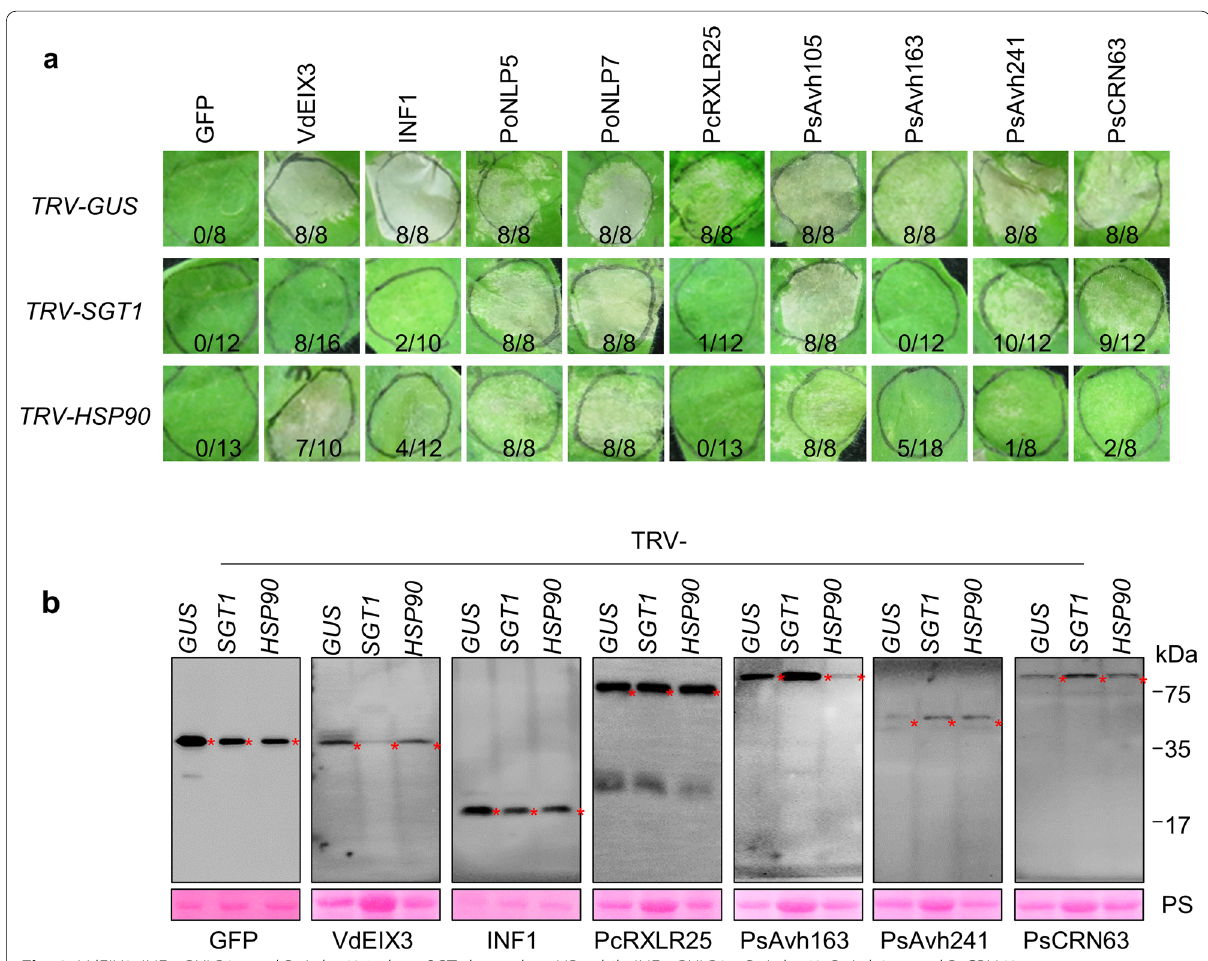
Fig. 2 VdEIX3, INF1, RXLR25 and PsAvh163 induce SGT-dependent HR, while INF1, RXLR25, PsAvh163, PsAvh241 and PsCRN63 cause HSP90-dependent HR. a Phenotypes of eight oomycete effectors in GUS- , SGT1- and HSP90 -silenced leaves. INF1, PoNLP5, PoNLP7, PcRXLR25, PsAvh105, PsAvh163, PsAvh241 and PsCRN63 were transiently expressed individually through Agrobacterium infiltration in gene-silenced leaves of N. benthamiana . Agrobacterium was infiltrated at an OD600 of 0.5 and the plants were imaged at 6 dpi. Consistent results were observed from three independent biological replicates. Numbers represent the number of leaves showing cell death out of the number of leaves analyzed. b Western blot detection of the effectors that trigger SGT1 or HSP90-dependent cell death. The accumulation of VdEIX3, INF1, PcRXLR25, PsAvh163, PsAvh241 and PsCRN63 in GUS- , SGT1- and HSP90- silenced plants. GFP was used as a test control. Total proteins were extracted from the leaves at 36 hpi, and protein accumulation was determined using anti-GFP or anti-HA antibody. In western blots, total protein loading was confirmed by Ponceau